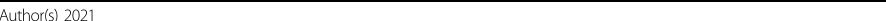
● Figure 7B: the underlying data for this fi gure has been manipulated. ● The article suggests that the Western blots and RT-qPRC results in Figures 4 and 7 came from contemporaneous experiments. However, the investigation found that the western blotting and the mRNA determinations had been performed by different researchers more than a year